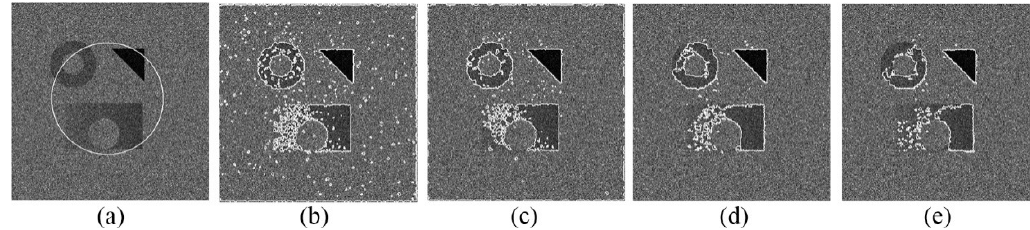
Figure 1. Segmentation results of a simulated synthetic aperture radar (SAR) image. Its size is 512 × 512. ( a ) Original SAR image and initial contour. ( b – e ) Results from different parameters: λ = 0.05, 0.1, 0.5, 1.0,